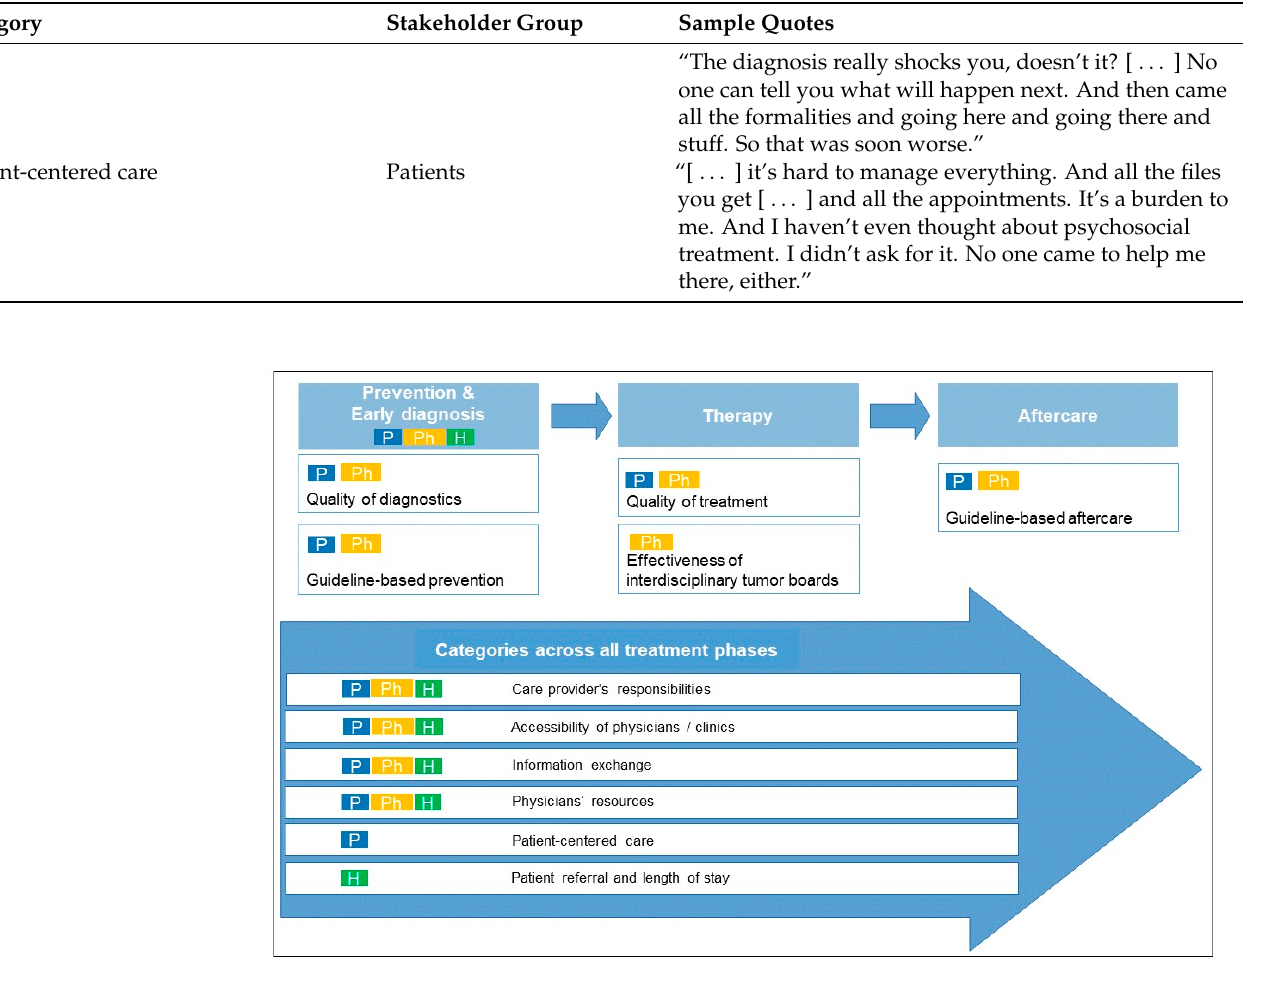
Figure 1. Categories of the needs analysis with assignment to the phases of pretreatment and treatment and the stakeholder groups. P = Patients, Ph = Physicians, H = Health insurance company representatives. Table 3. Overview of the categories generated for the optimization potential in the care of patients with skin cancer in the study region.